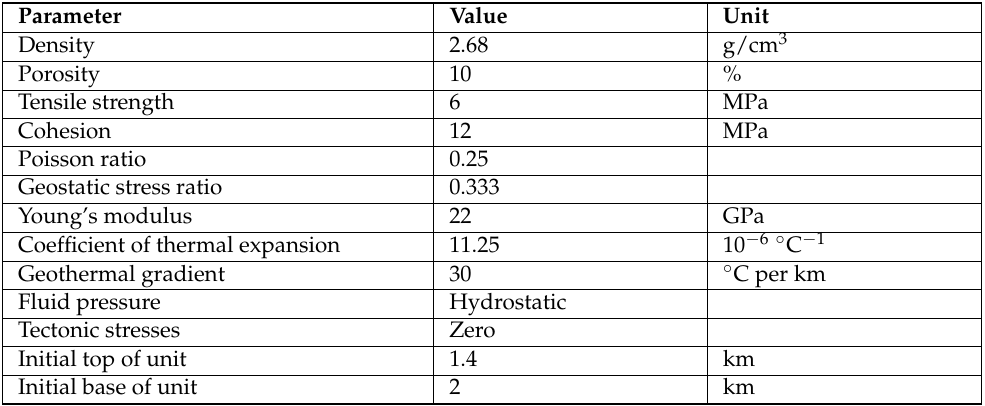
Table 5. Initial values used for modelling the effects of exhumation and cooling on the Bunter Sandstone. Parameter Value Unit Density 2.68 g/cm 3 Porosity 10 % Tensile strength 6